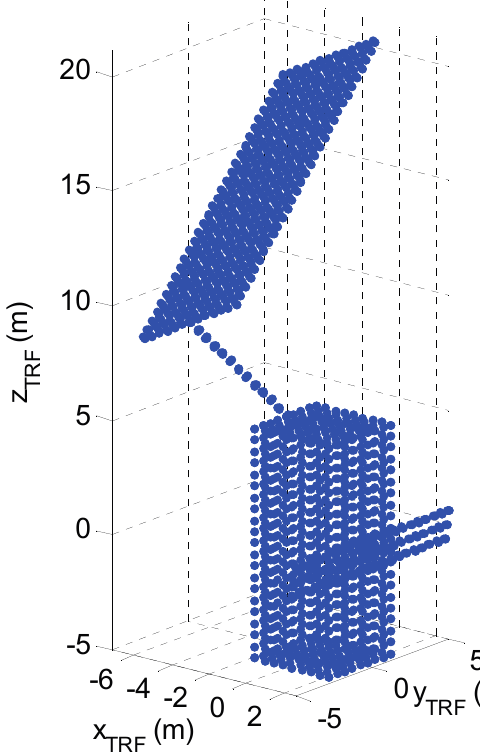
Figure 3. ENVISAT model point cloud represented in the